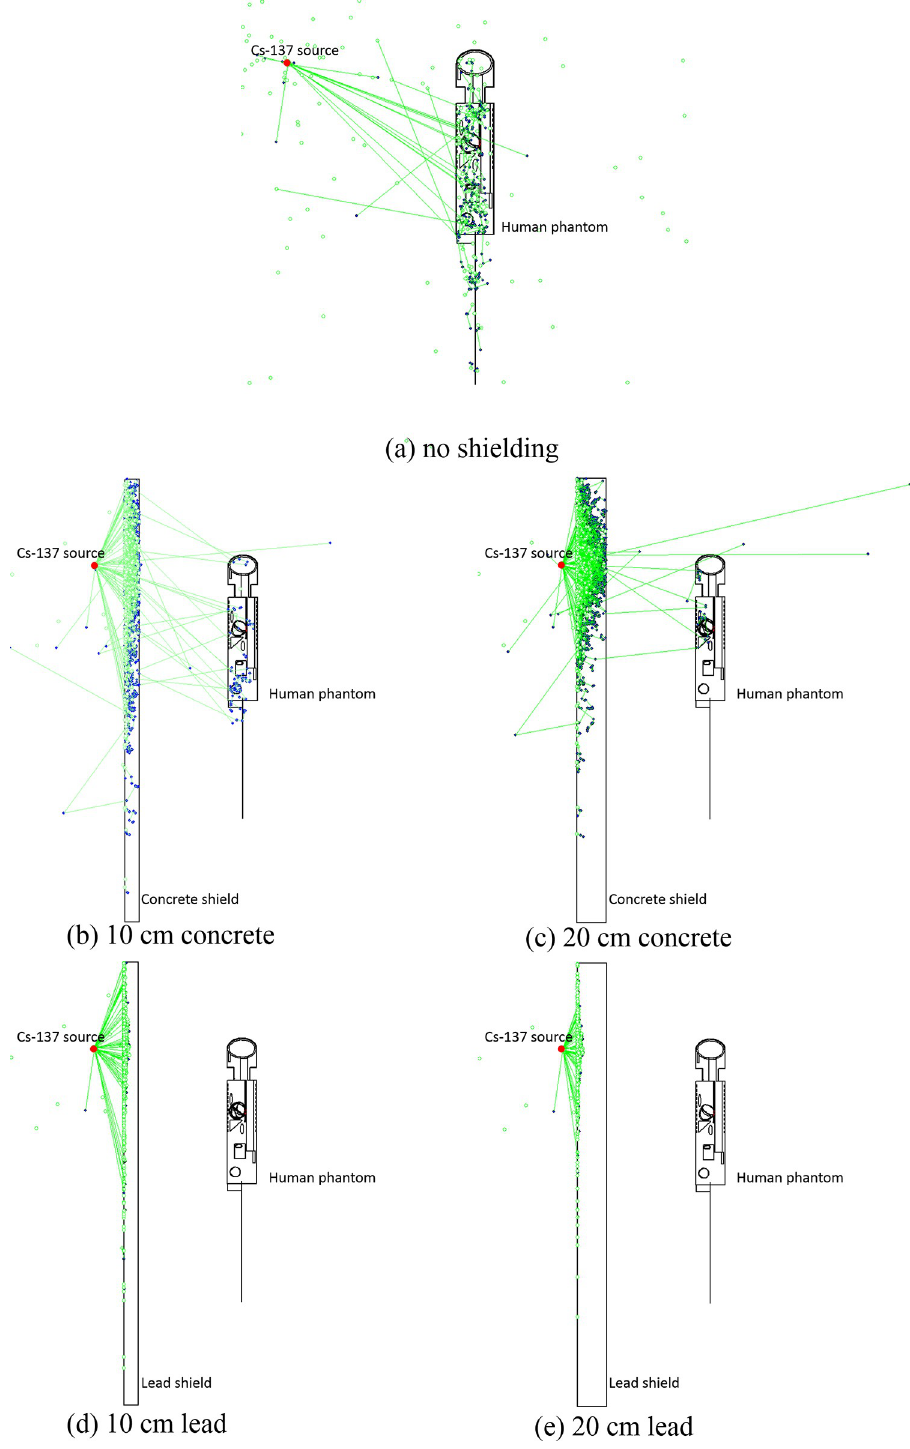
Fig 4. Graphical representation of photon tracks for the cases with (a) no shielding, (b) 10 cm concrete, (c) 20 cm concrete, (d) 10 cm lead and (e) 20 cm lead shielding. Blue dots: positions of photon interactions; green lines: links between positions of multiple interaction (i.e., blue dots); green open circle: positions at which photons would not undergo further multiple scattering. Some symbols may have overlapped with one another. For a better understanding, the readers could cross check with the video clips, where the symbols are displayed in